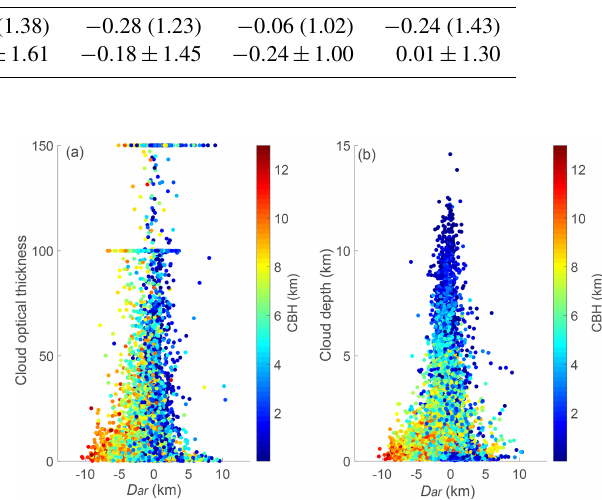
Figure 10. Scatter plot illustrating the relationship of (a) the D ar and the COTs and (b) the D ar and the